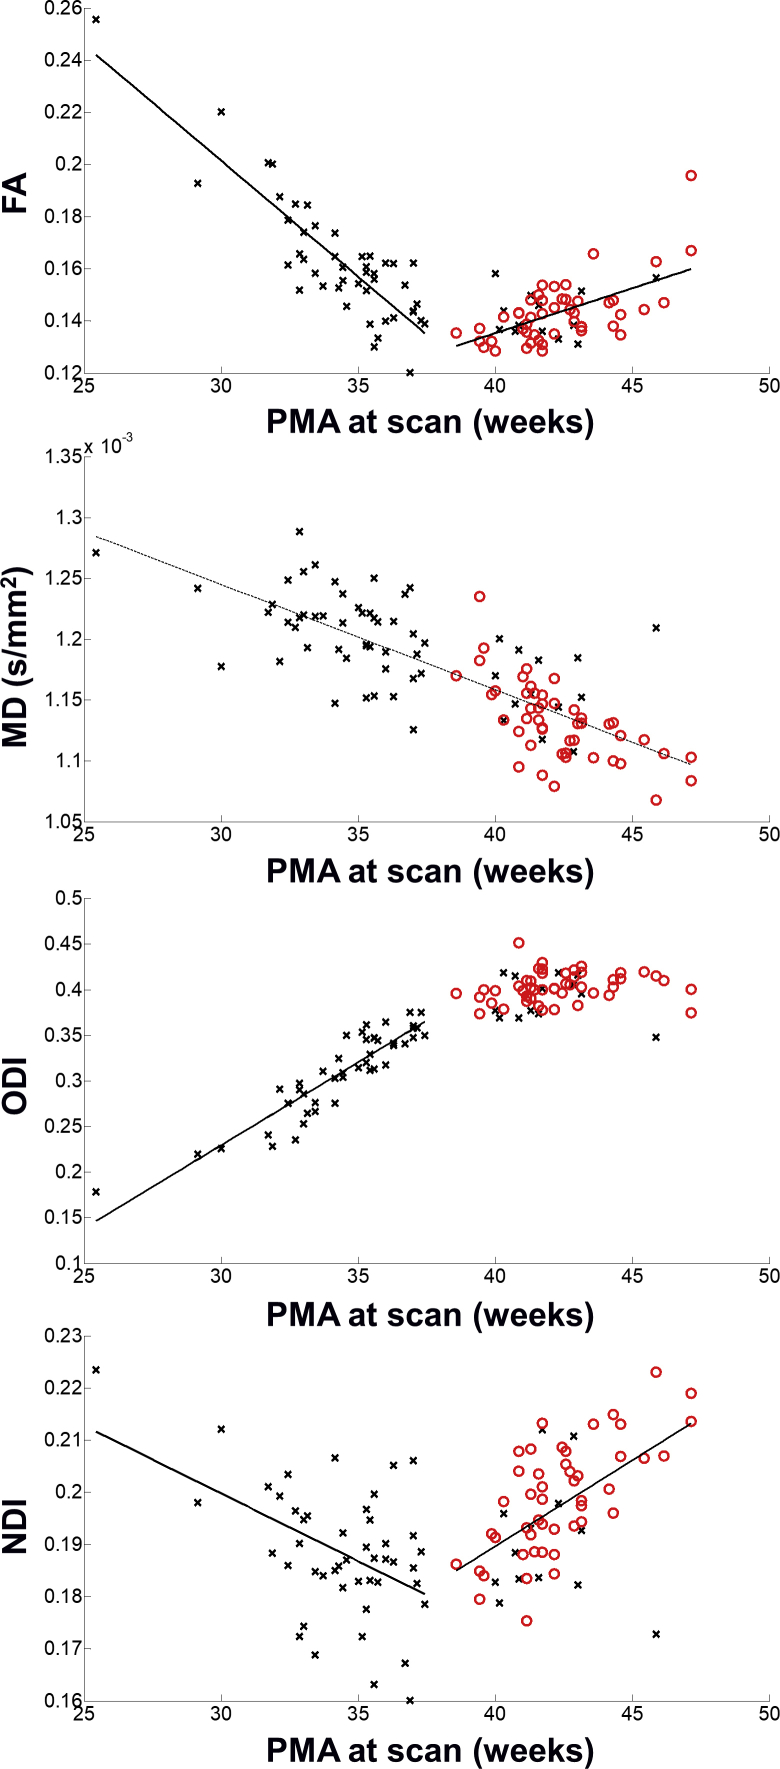
Whole-brain (GM) microstructural characteristics versus age, discriminating for coil type. Note the consistency of results across different coil types. Red circles for 8-channel coil, black crosses for 32-channel coil.